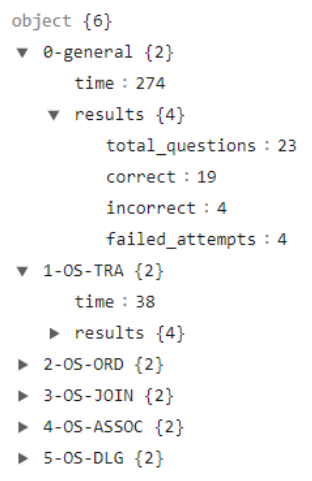
Figure 7. JSON file of results and time.